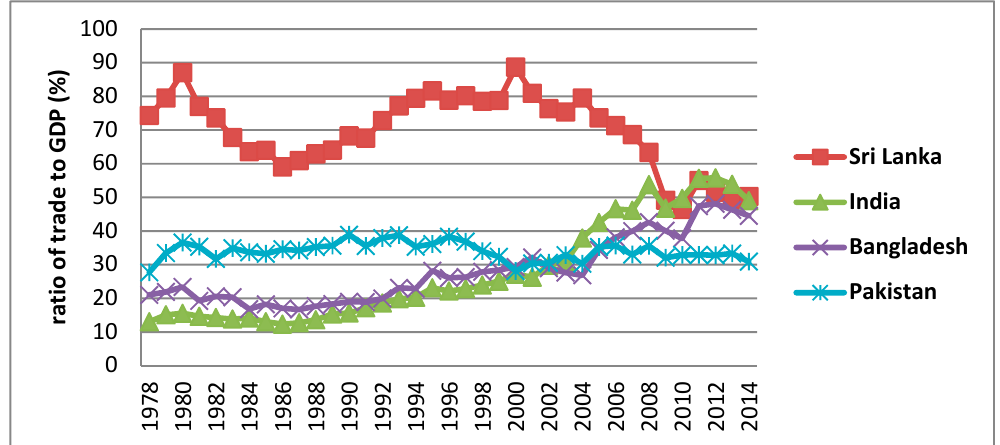
Figure 1. Trade openness in selected South Asian countries.